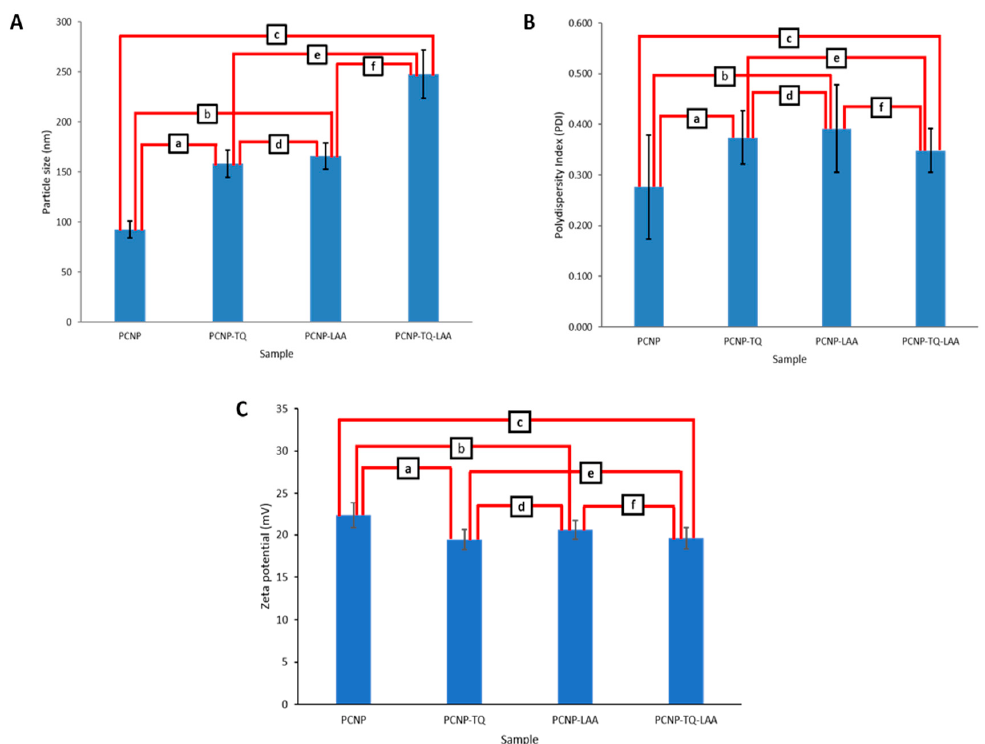
Figure 6. ( A ) Particle size of PCNP, PCNP-TQ, PCNP-LAA and PCNP-TQ-LAA, with t -test conducted to see the significance of particle size changes between samples. The confidence level was set to 95% and the results are labelled as a to f. (a) Significant ** with a p- value of 0.0022, (b) significant ** with